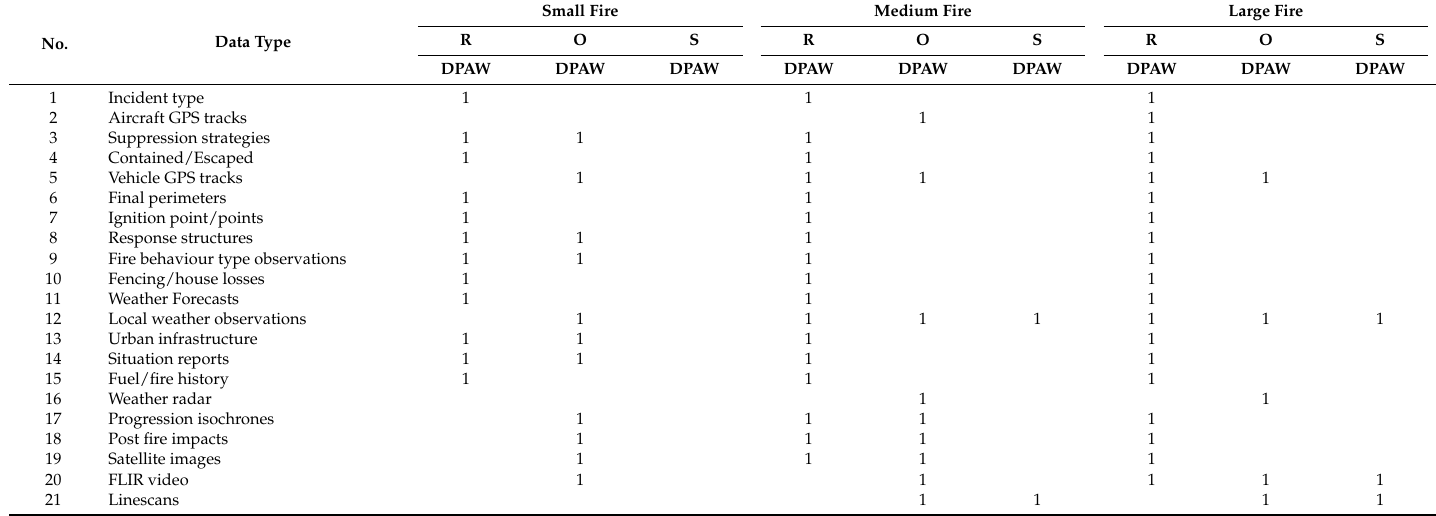
Table A8. Western